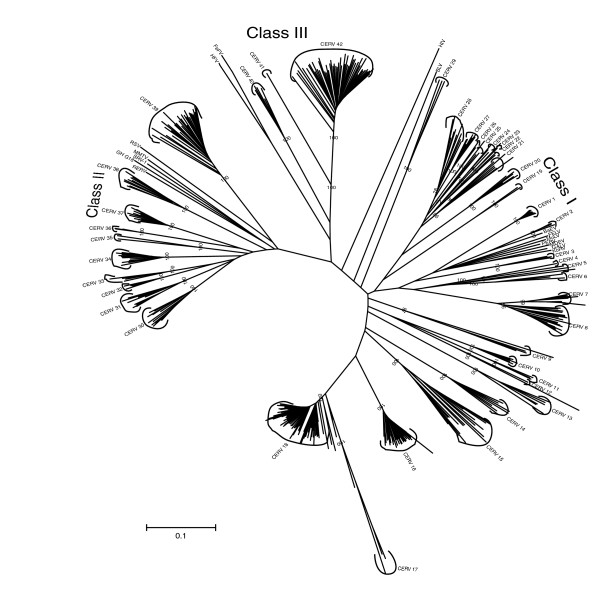
Unrooted RT based neighbor joining tree of three classes of chimpanzee endogenous retroviruses: class I, CERV1 to CERV29; class II, CERV30 to CERV 39; class III, CERV 40 to CERV 42. Bootstrap values are shown for each of the families. RT sequences from species other than chimpanzee, listed in Table 1, are included for comparison.